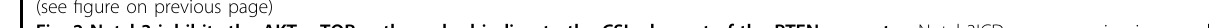
relationship between the risk of death and PTEN expression. Therefore, we evaluated the relationships between Notch3 and PTEN expression and the patho- logical parameters of 250 human invasive ductal carci- noma tissue samples. Positive Notch3 expression was found in 162 of the 250 specimens (64.8%) (Fig. 5b – d) and the Notch3-negative shown in Fig. 5a. PTEN expression was positive in 172 of the 250 samples Fig. 5e. The different expression levels of Notch3 and PTEN shown in Fig. 5a – h. The relationships between Notch3 and PTEN expres- sion and the pathological features of breast cancer cases are presented in Table 1. A signi fi cant positive relation- ship between Notch3 or PTEN expression and lower N3 lymph node involvement was observed. Notch3-positive patients were signi fi cantly higher in N0 (69.6%) and N1 groups (71.4%) compared to the N2 (54.3%) and N3 (45.5%) groups ( P = 0.020). PTEN-positive patients were higher in N0 (79.3%) and N1 groups (74.0%) compared to the N2 (55.7%) and N3 (27.3%) groups ( P < 0.001). As shown in Table 1, Notch3 was positively related to the estrogen receptor (ER), progesterone receptor (PR), lower incidence of nodal involvement, and lower Ki-67 index. Of the 162 patients, the Notch3 positivity rate was sig- ni fi cantly higher in ER + (112/162; 69.1%) than ER − (50/ 162; 30.9%) breast cancer ( P = 0.020). It was also higher in PR + (104/162; 64.2%) than PR − (58/162; 36.3%) breast cancer ( P = 0.044). Thus, Notch3 expression was posi- tively correlated with both ER and PR expression. Simi- larly, a relationship was observed between PTEN and the estrogen receptor (ER), Ki67 expression, and nodal status. Out of 172 PTEN-positive patients, the PTEN positivity rate was higher in ER + (125/172; 72.7%) than ER − tumors ( P < 0.001). Patients in the Ki-67-negative group were also more likely to be de fi ned as Notch3-positive (Notch3-positive frequency: 80/108; 74.1%, P = 0.007).